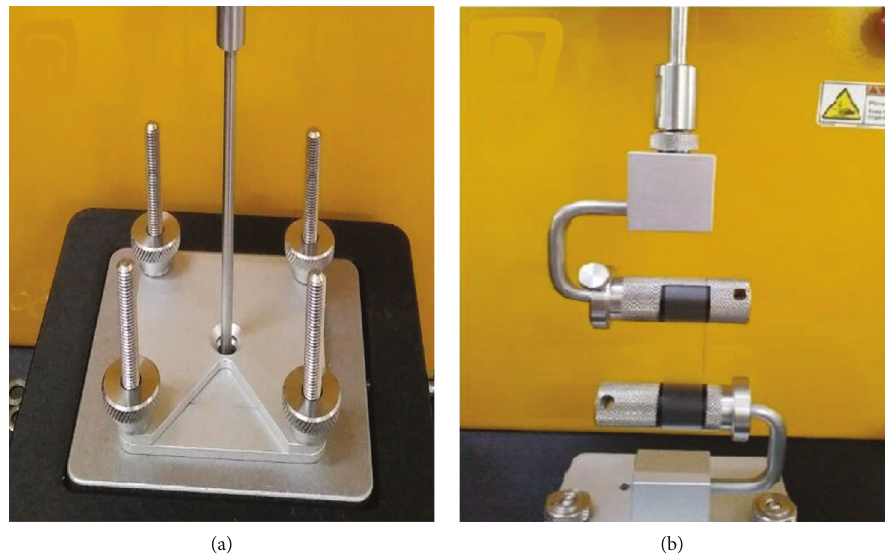
Figure 2: Experimental setups for the puncture (a) and tensile (b) strength tests.